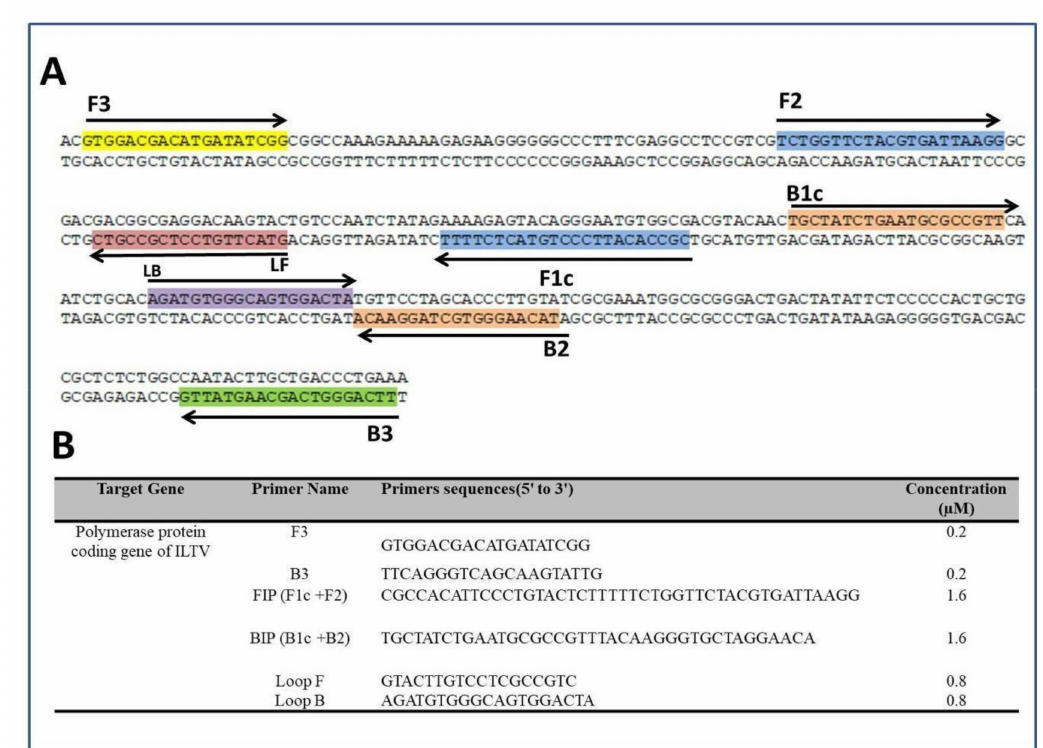
Figure 1. LAMP primers on the ILTV amplicon. ( A ) ILTV amplified sequence with the primers sites: forward primer (F3), backward (B3) primer, backward inner primer (BIP), forward inner primer (FIP), loop forward (LF) primer, and loop backward (LB) primer shown. Arrows and colored nucleotides show the direction of extension and the targeted sequences, respectively. ( B ) Primers sequence for ILTV LAMP